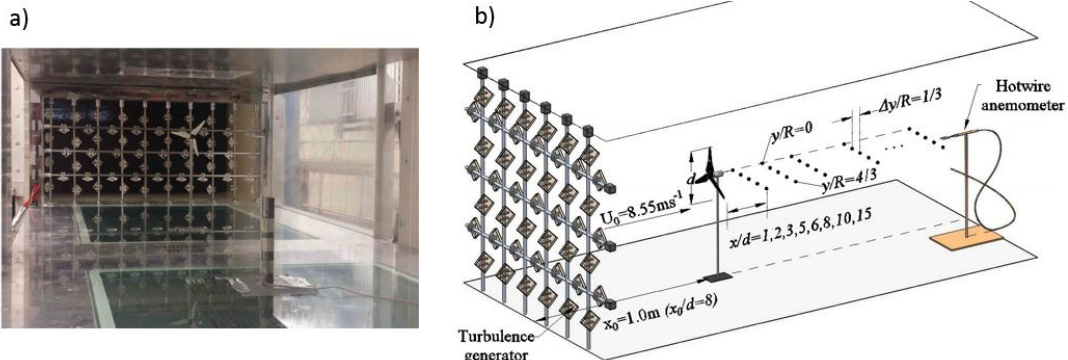
Figure 1. ( a ) Photograph of the turbulence generator TG at the beginning of the test section, and the model turbine; ( b ) schematic of the experimental setup. The origin of the coordinate system ( x , y ) = ( 0, 0 ) is set at the center of the